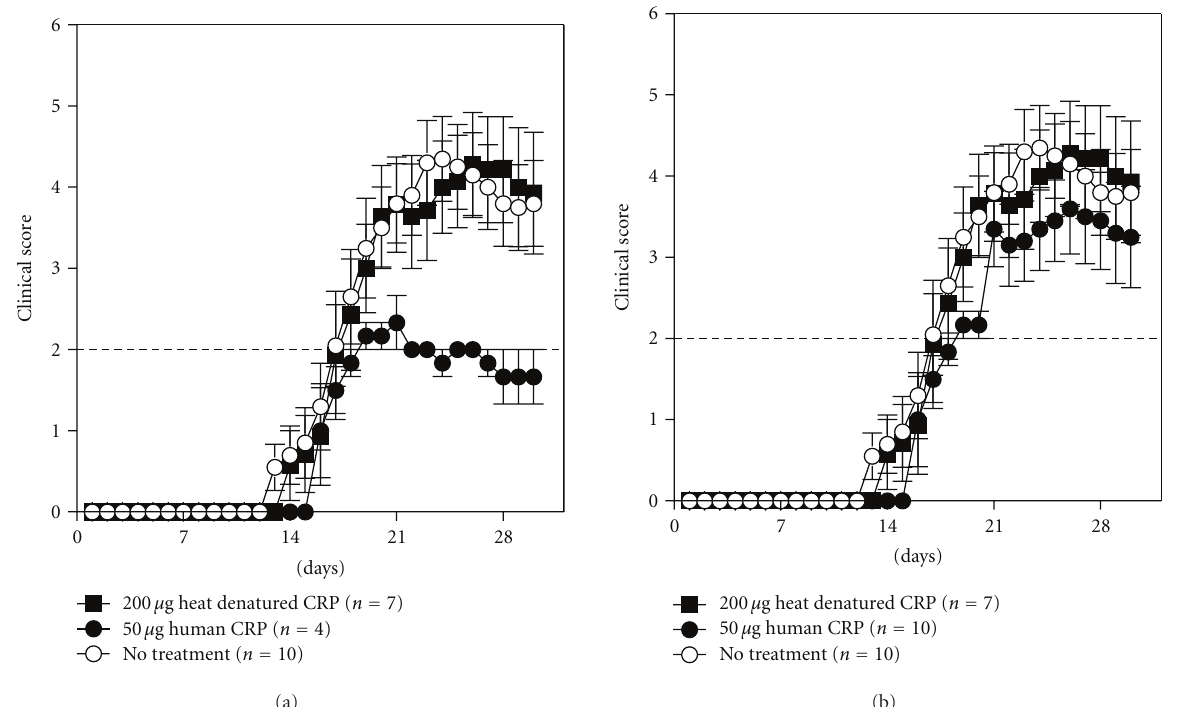
Figure 3: CRP treatment stalls progression of EAE in wild-type mice but not in Fc γ RIIB − / − mice. Wildtype (a) versus Fc γ RIIB − / − (b) with ongoing EAE were injected with 50 μ g purified CRP s.c. when their clinical scores reached 2 (horizontal line), and EAE symptoms were monitored for 10 days. Controls received heat-denatured